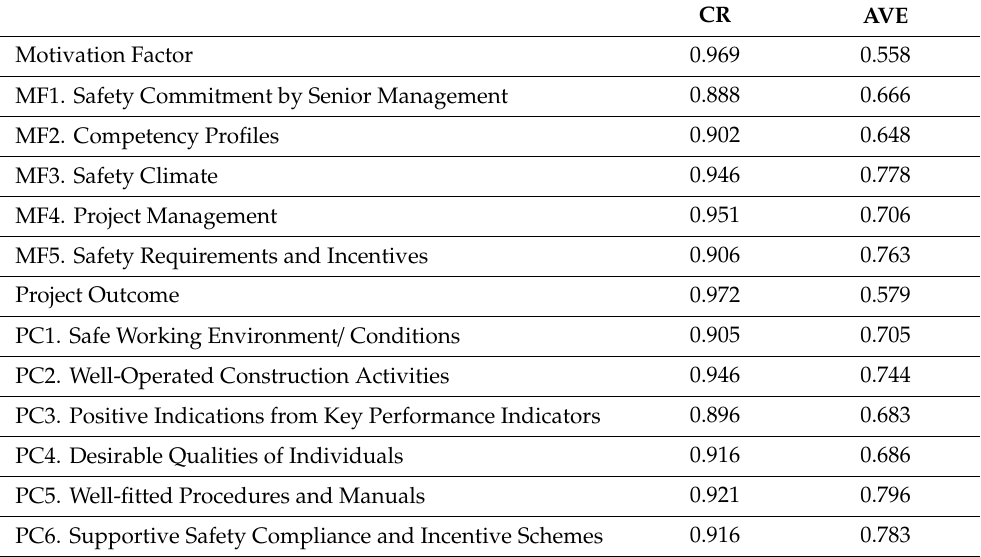
Table 5. Composite Reliability (CR) and Average Variance Extracted (AVE) of the Structural